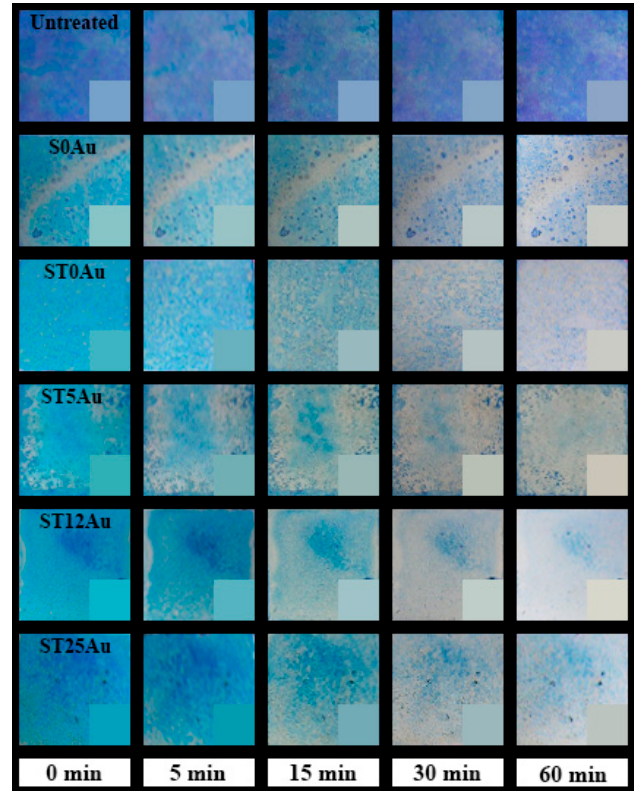
Figure 8. Photographs of evolution of decolourization of dye, deposited on the stone samples, during the first 60 min of the photodegradation test, the photographs correspond to the whole sample surfaces, 5 × 5 cm. The insets include the digital reproduction of the stone colour from the colour coordinates.